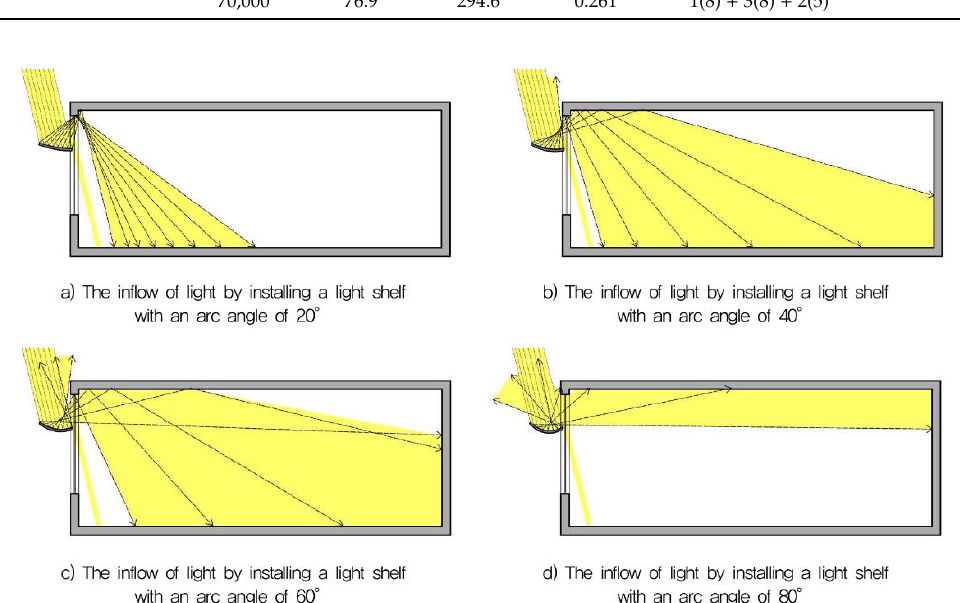
Figure 14. Uniformity ratio versus light shelf angle and arc angle during summer (external illuminance: 80,000 lx). During mid-season, a curved light shelf showed different results depending on the light shelf angle and arc angle, as shown in Table 9; however, the system was effective in reducing lighting energy when the arc angle was 40°. This means that the daylighting performance cannot be improved by simply increasing the curvature of the light shelf. As shown in Figure 15, the uniformity ratio increased until the arc angle reaches 40° during the mid-season, but it decreased beyond 60°. Further, this showed that simply increasing the curvature of a light shelf reflector does not improve its performance. During mid-season, a curved light shelf with an angle of 30° effectively resolved the issue of uncomfortable glare due to light diffusion into the room by reflecting natural light onto the ceiling (Figure 15). In addition, as shown in Figure 16, a flat light shelf with an angle of 30° exhibited a low uniformity ratio, whereas a curved light shelf exhibited a better uniformity ratio even when the angle was 30°. Thus, curved light shelves could reduce the discomfort caused by glare by diffusing the external natural light, whereas flat light shelves only produce mirror reflections. In summary, the optimal values for a curved light shelf during mid-season were found to be a light shelf angle of 30° and an arc angle of 40°.